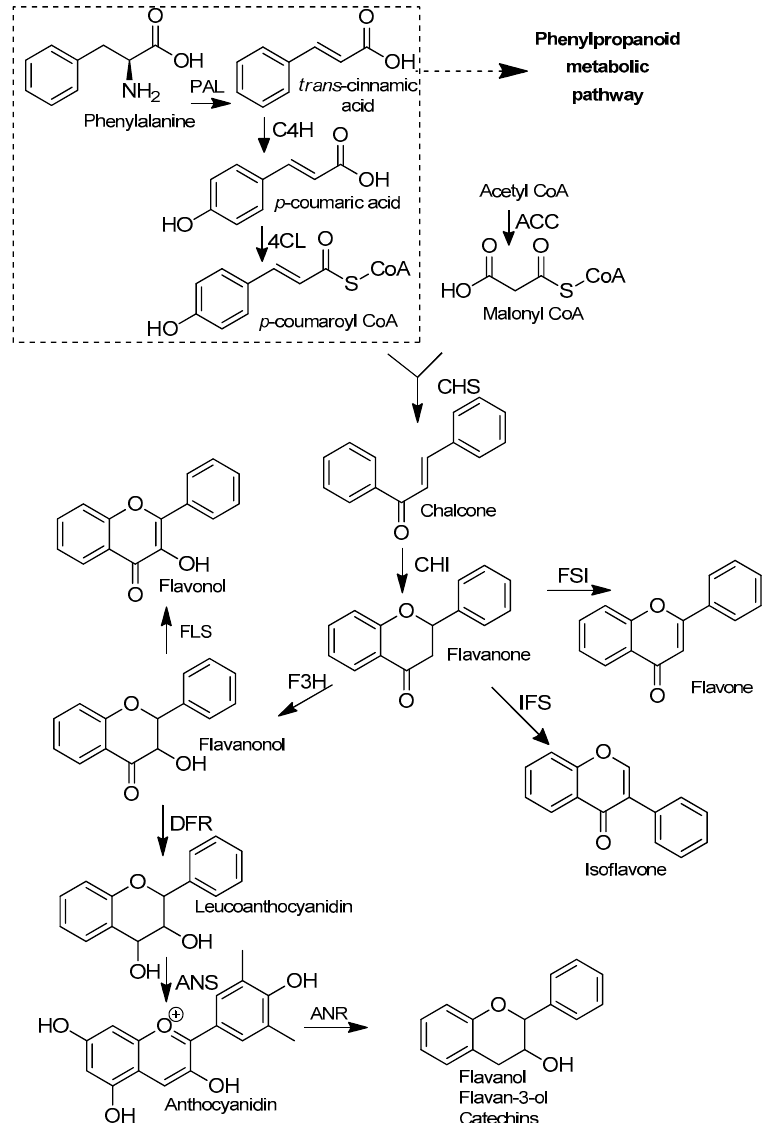
ff olds. PAL: phenylalanine ammonia-lyase; Figure 6. Biosynthetic pathway of flavonoid scaffolds. PAL: phenylalanine ammonia-lyase; C4H: Figure 6. Biosynthetic pathway of flavonoid sca